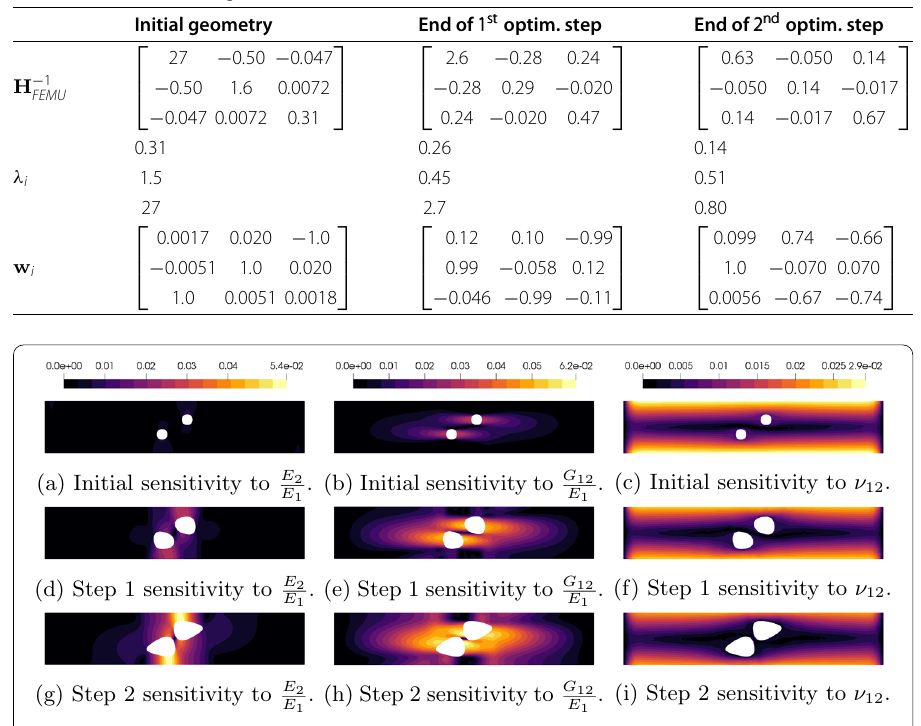
, G 12 E , ν 12 ), its eigenvalues 1 1